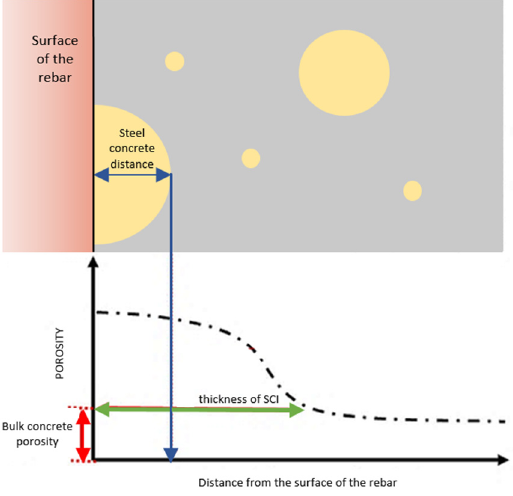
Figure 3. E ff ect of steel-concrete distance on the porosity and thickness of SCI (Reproduced with permission from reference [29]).